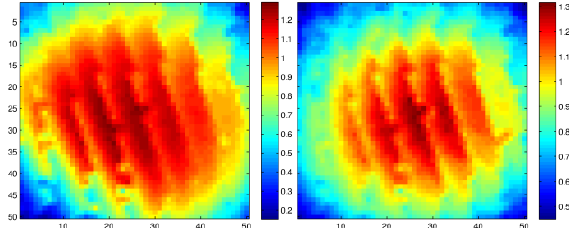
Figure 5. LUT coefficients at 550 nm (left) and 770 nm (right) To validate the stability of the flat field calibration across different light intensities we applied the flat field coefficients stored in the LUT to measurements at different light intensities (Table 1). Overall, with doubling the light intensity the DN values have a range less than 8 percent relative to the mean with a coefficient of variation close to zero.